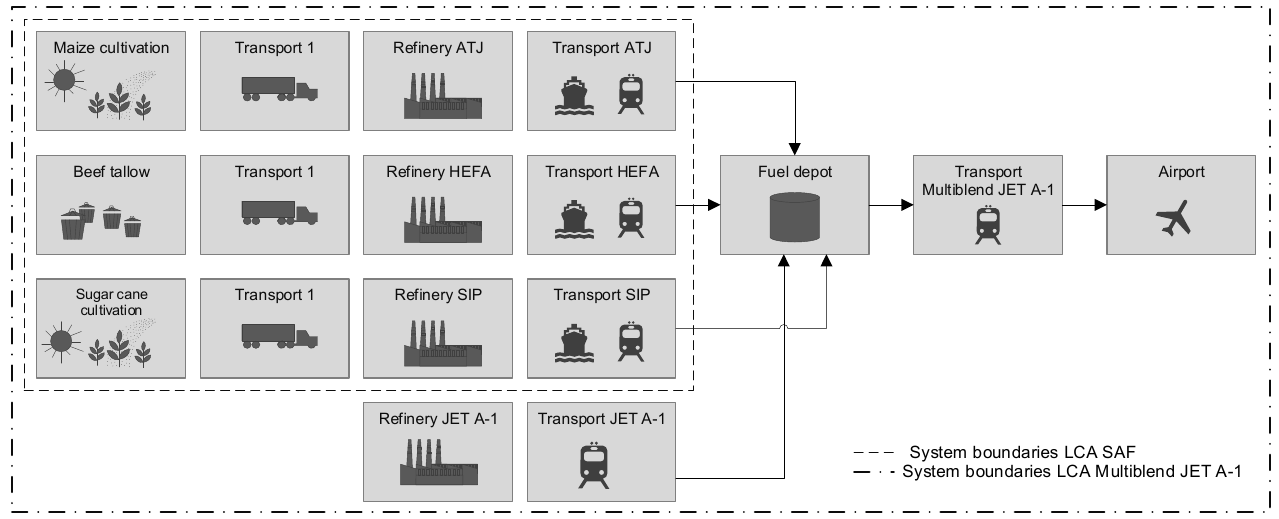
Figure 1. System boundaries for SAF and multiblend assessment. The figure shows case B supply chain. SIP is not included in case A.